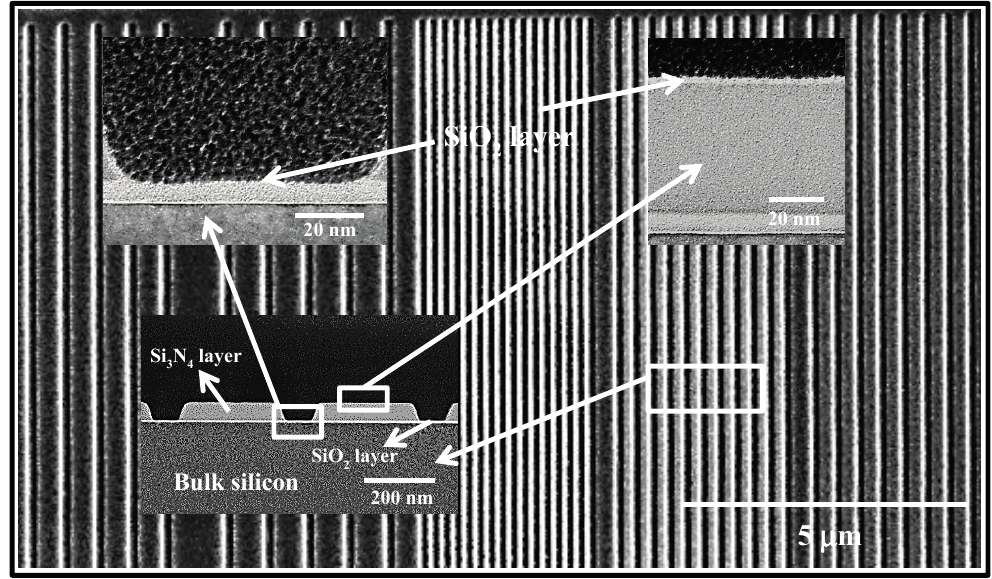
Figure A3. Top-down SEM image of a section of a topographically patterned Si 3 N 4 substrate depicting different pitches. Insets shows high resolution cross-section TEM images and demonstrate the composition and depth profile of the